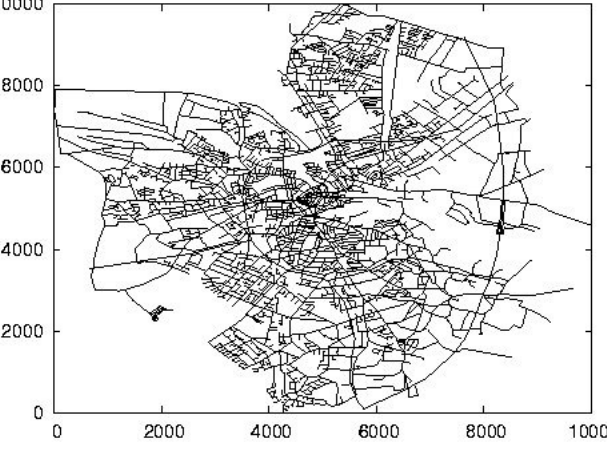
Figure 5. Oldenburg road